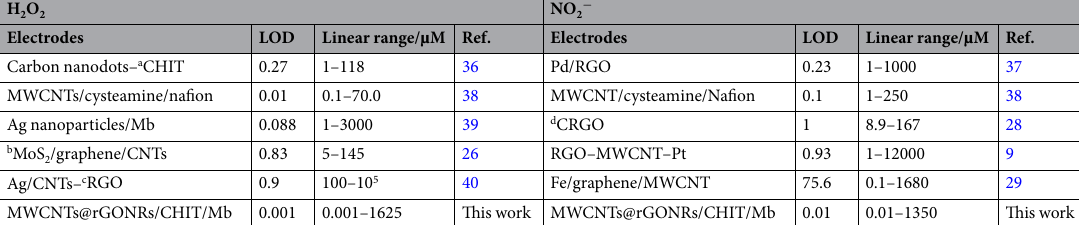
Figure 5D, displayed the amperogram acquired at MWCNTs@rGONRs/CHIT/Mb electrode upon each successive additions of NO 2 − . The E app was + 0.70 V. The plot between concentration of NO 2 − and current